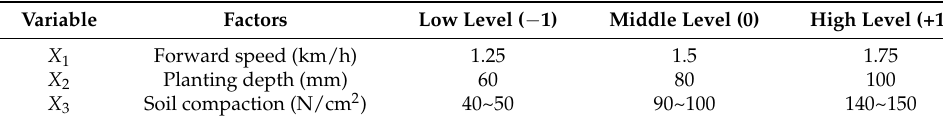
Table 4. Factors and levels.